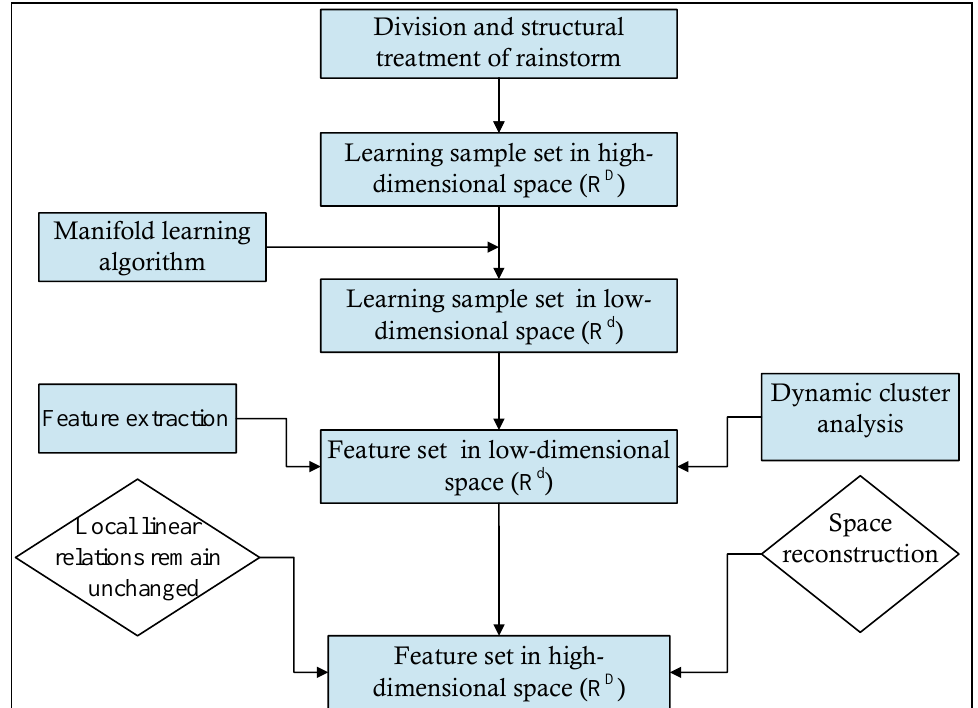
Figure 2. Schematic diagram.